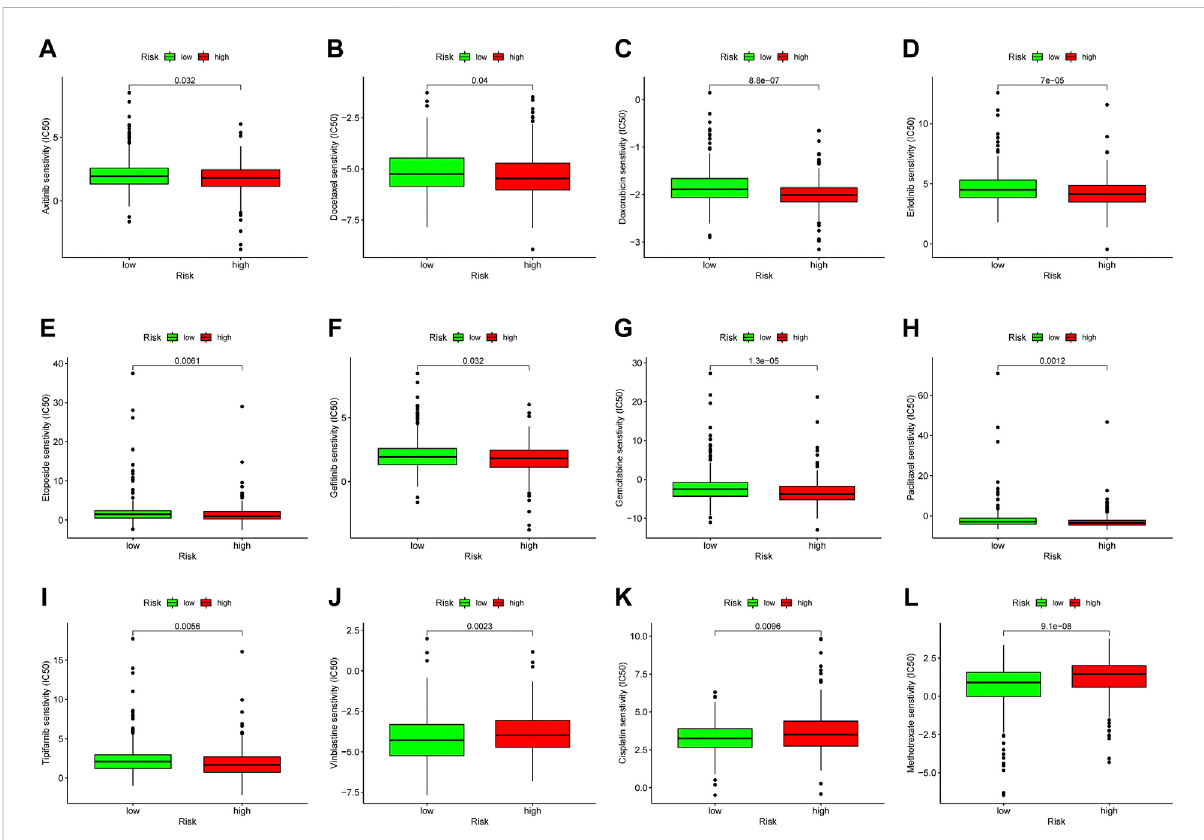
FIGURE 9 Drug sensitivity analysis. The IC50 of Axitinib, Erlotinib, Doxorubicin, Bortezomib, Ge fi tinib, Gemcitabine, Paclitaxel, Tipifarnib, Vinblastine, Vinblastine, Cisplatin and Methotrexate was analyzed in high-risk and low-risk groups (A – L)